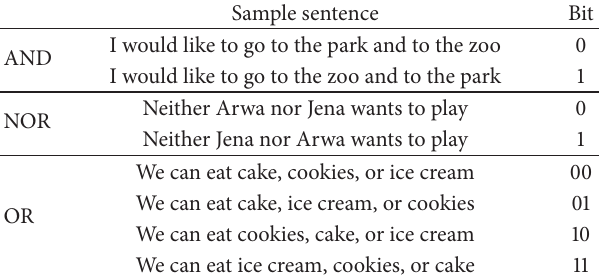
Table 1: Boolean operators encoding.